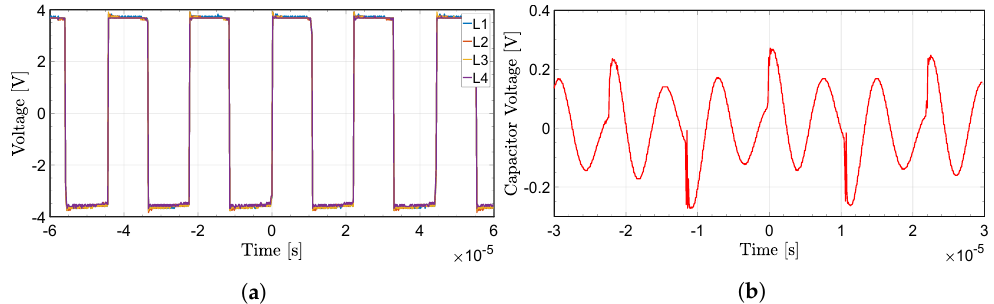
Figure 17. ( a ) Inductor voltage waveforms of the proposed ´cuk balancing circuit; and ( b ) capacitor voltage waveforms of the proposed ´cuk balancing circuit.